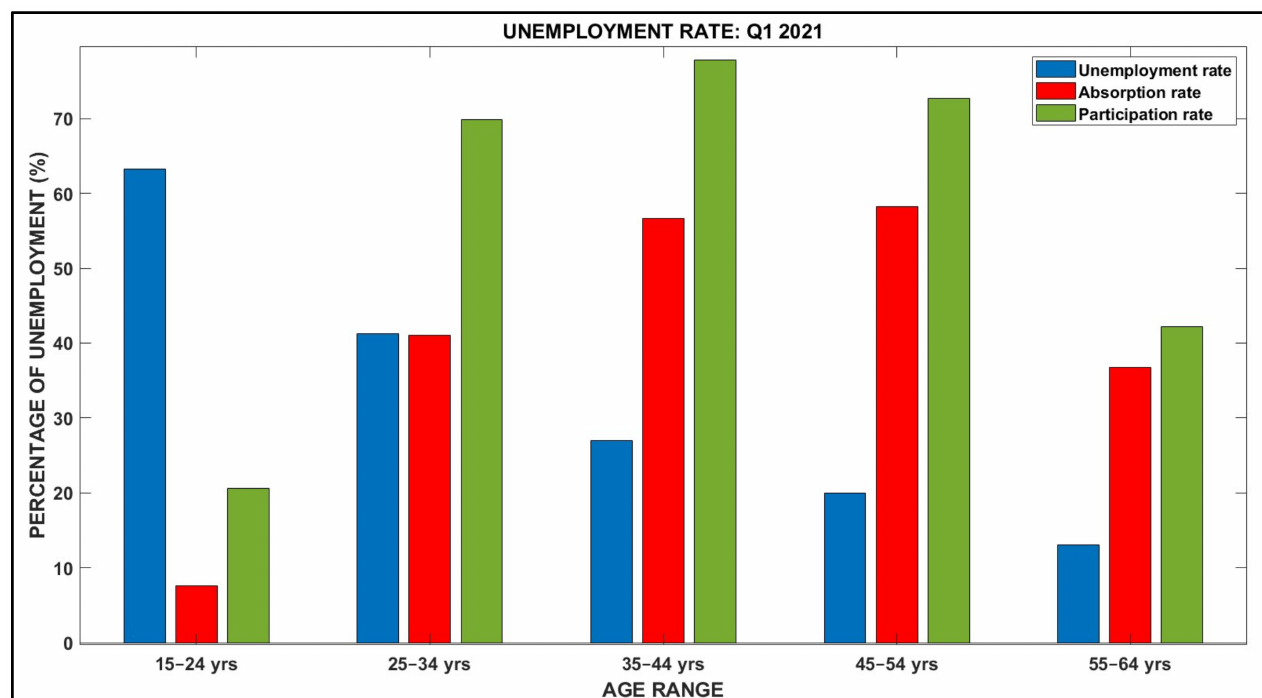
Figure 6. Unemployment rate in South Africa (Adapted with Copyright and disclaimer permission from Reference [85]. 2021, Statistics South